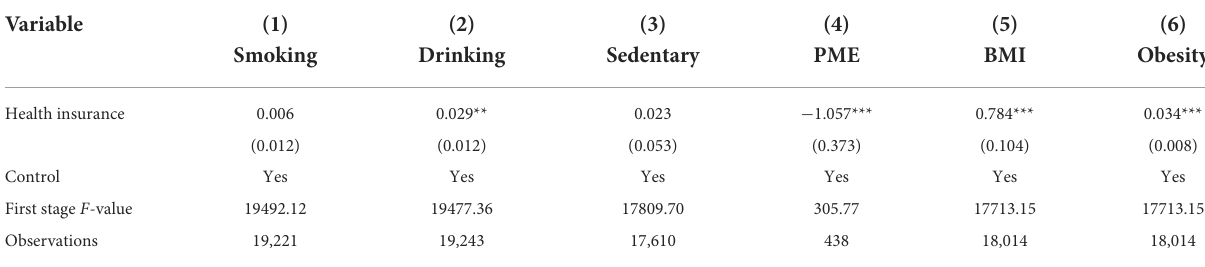
TABLE 11 Robustness check